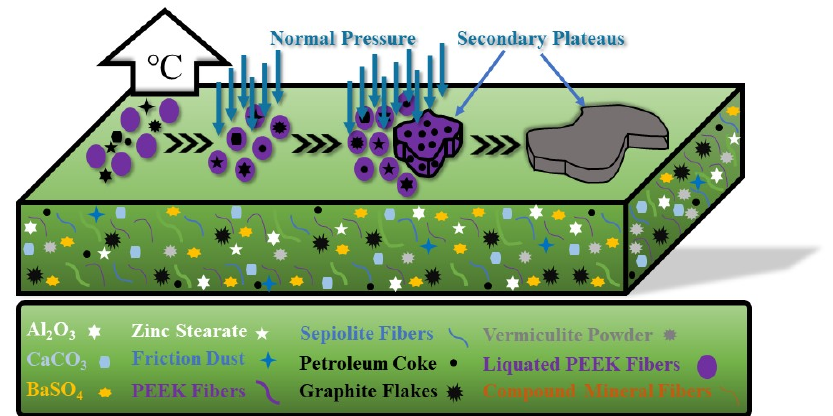
Figure 12. The formation of secondary plateaus.